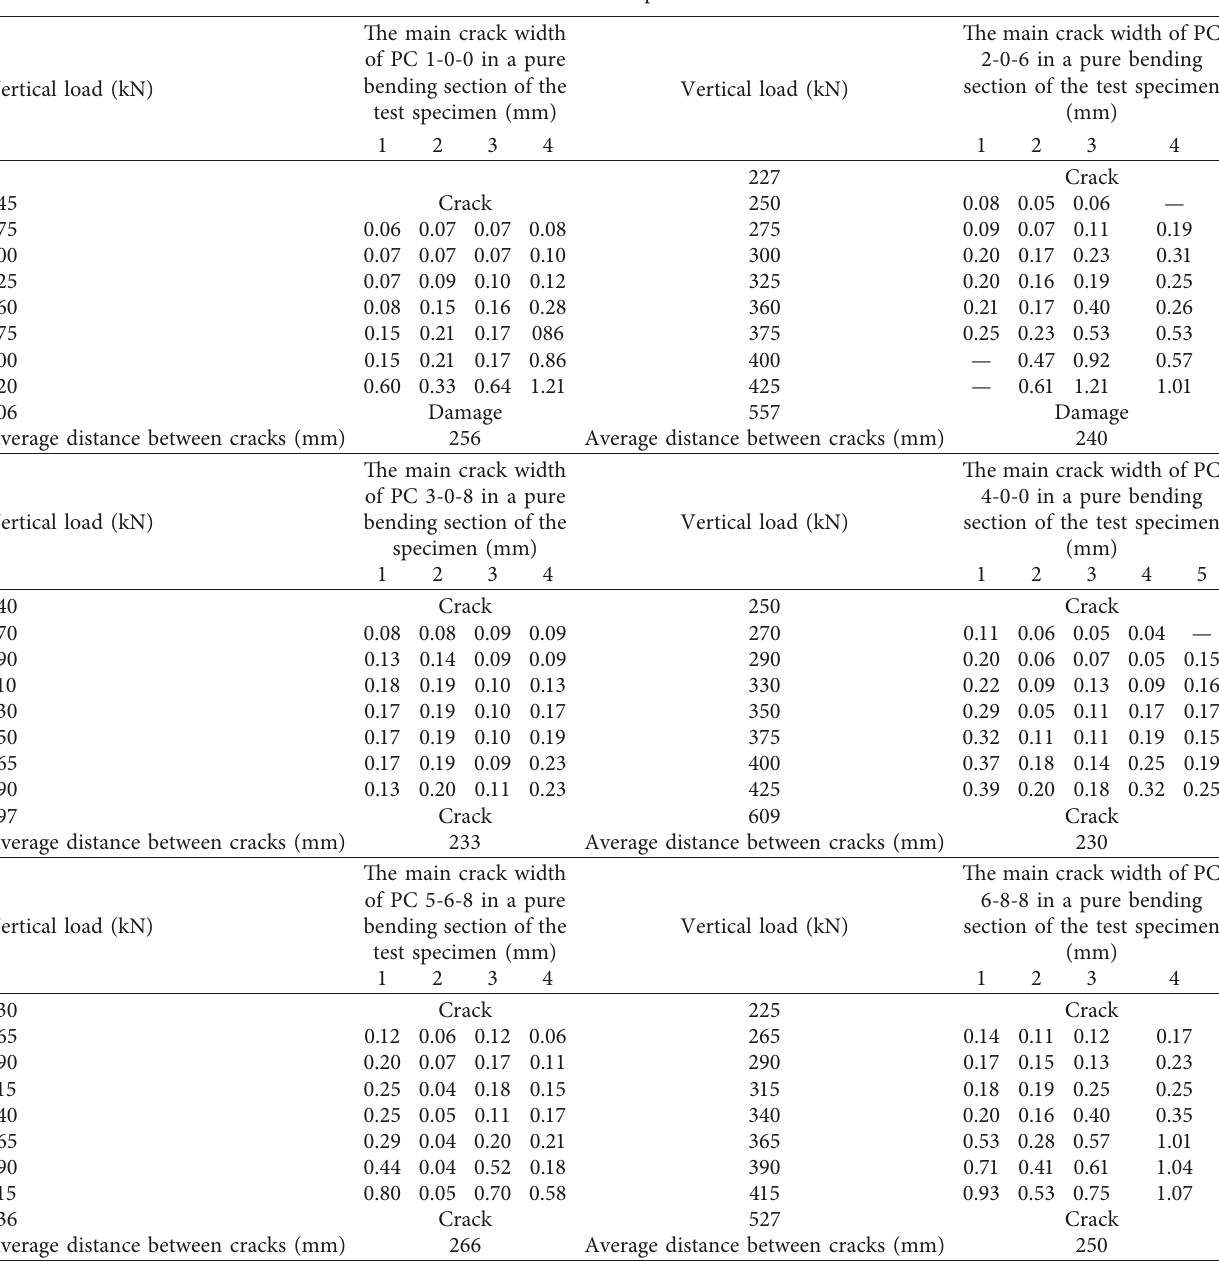
Table 3: Crack development